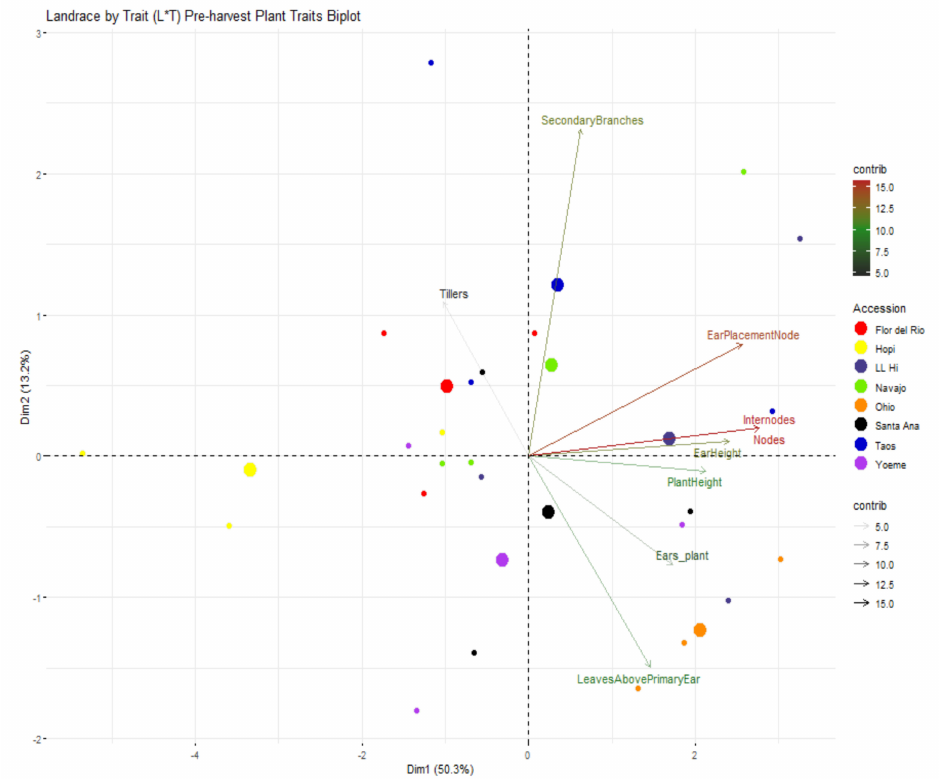
Figure 7. Landrace by trait (L*T) biplot for pre-harvest plant traits. Landraces from Navajo Blue, LL High, Santa Ana Blue, Flor del Rio, Yoeme Blue, Ohio Blue, Hopi Blue, and Taos Blue are shown in “chartreuse2”, “slateblue4”, “black”, “red1”, “darkorchid2”, “darkorange”, “yellow” and “blue3”, respectively. Traits contributing to PC1 and PC2 are also assigned different colors with a gradient ranging from 5, 10, and 15 with “gray15”, ”forestgreen” and “firebrick”, respectively. Larger consensus points for each accession discerns the midpoint of a given